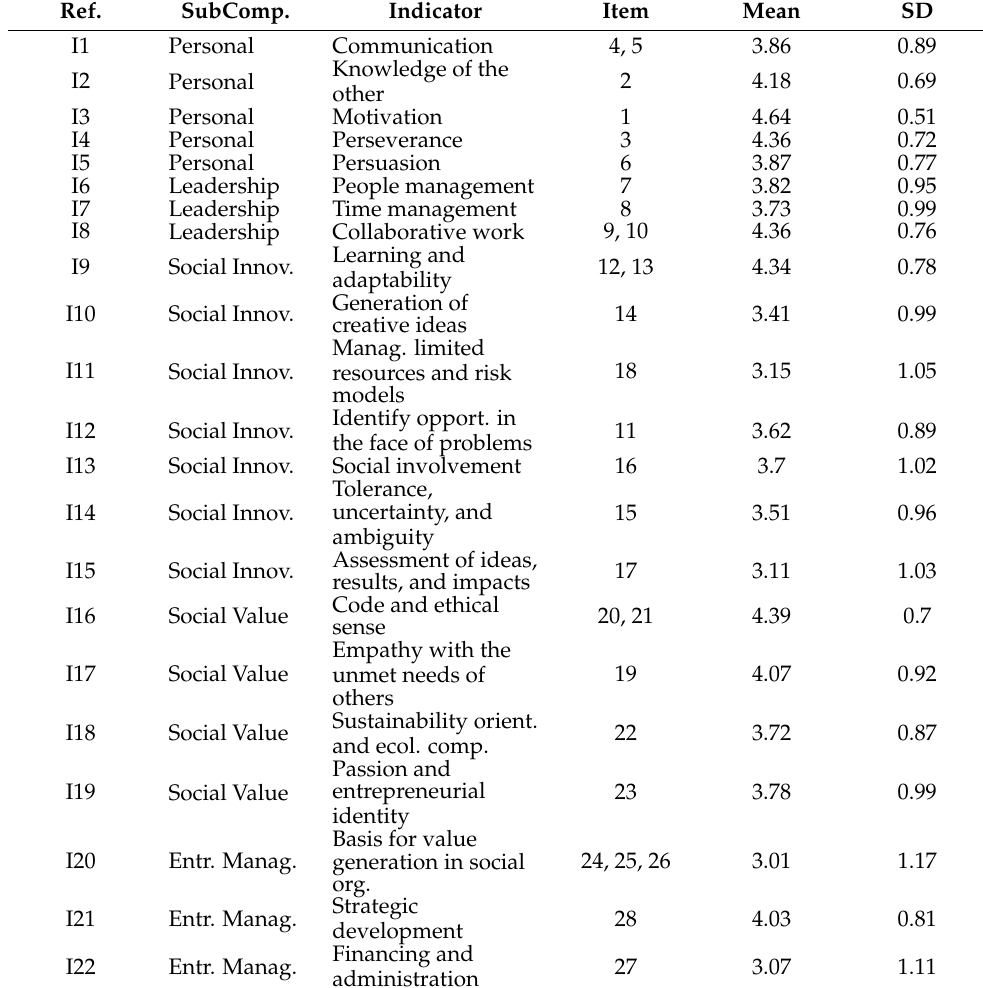
Table 3. Mean values and standard deviation of indicators by subcompetencies.